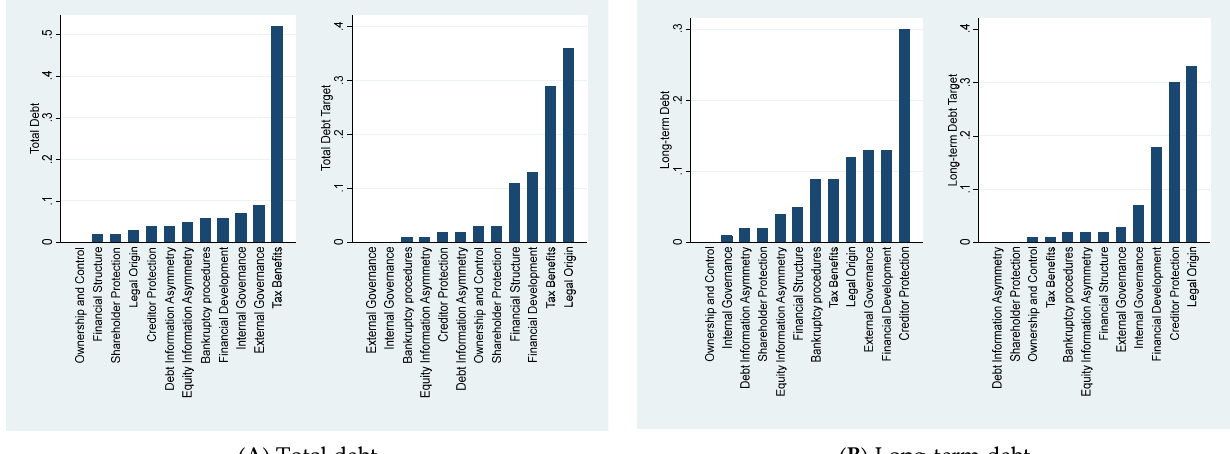
Figure 1. Variance decomposition analyses of actual and target capital structures and the effects of institutions and financial development. Notes: The figure plots the Type III partial sum of squares that is normalized by the sum across the effects of the institutional and financial development determinants estimated from Equation (6). The results for target leverage rely on Target 1, estimated using Blundell and Bond’s (1998) two-step system GMM. The definitions and the sources of the variables appear in Table 1.